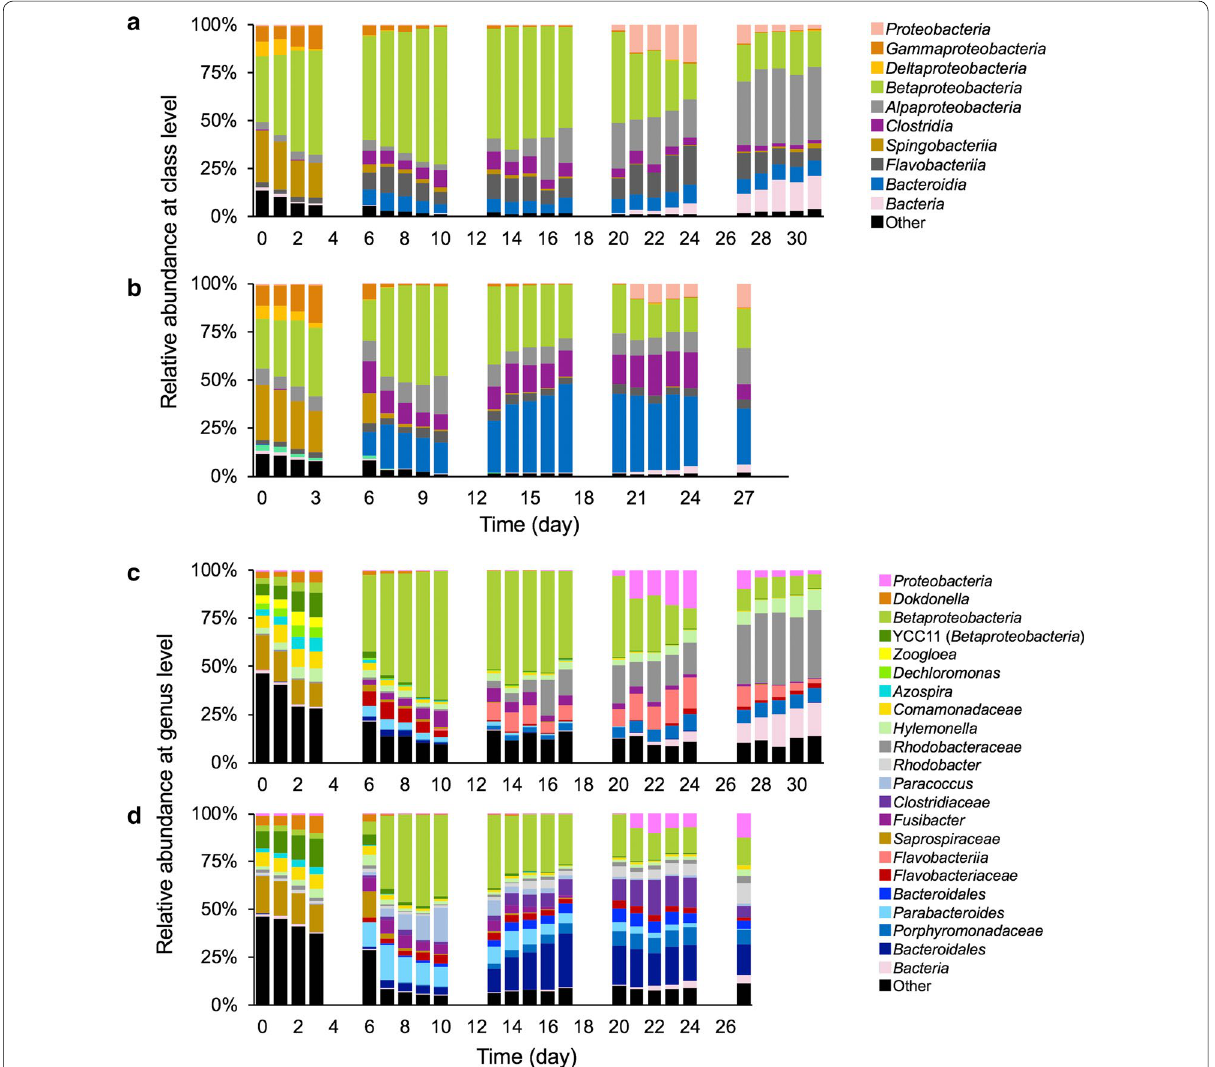
Fig. 3 Structural changes in the microbial communities at the class and genus levels throughout the operation. a , b Analysis at the class level in Reactors 1 and 2, respectively. c , d Analysis at the genus level in Reactors 1 and 2, respectively. The phylogenetic groups (class or genus) are indicated by color and their taxonomies are shown to the right of the graphs. Phylogenetic categories were assigned using QIIME